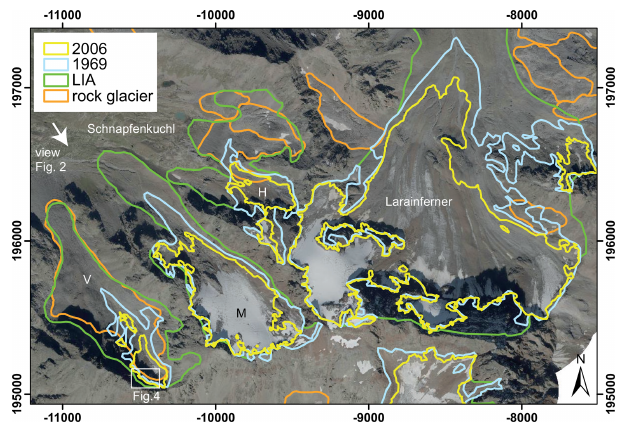
Figure 3. Overview of the Schnapfenkuchl glaciers V, M, and H in an orthophoto of 2020 with the information available prior to the new glacier inventory: the glacier margins of the former glacier in- ventories for LIA, 1969, and 2006 and rock glacier margins (Krainer and Ribis, 2012). While the ice margin of Schnapfenkuchl M and Larainferner is clearly visible, the delineation of Schnapfenkuchl V and H glaciers from the orthophoto can only be guessed at.